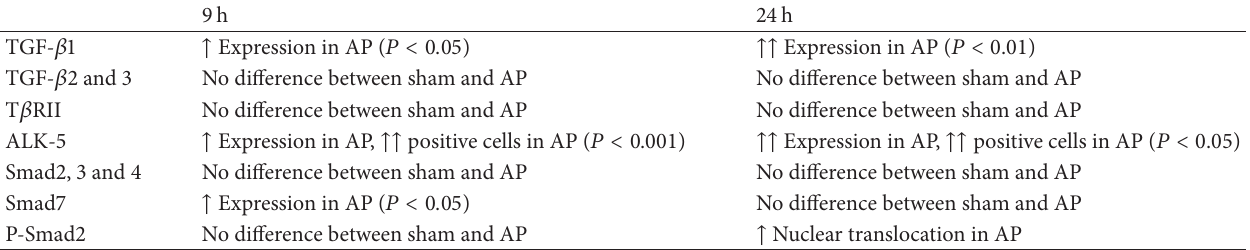
Table1:ChangesinexpressionpatternsofTGF- 𝛽 signalingmoleculesinthelungsduringacutepancreatitisattwotimepoints.Theexpression of TGF- 𝛽 signaling molecules in the lungs of AP compared to sham-operated animals based on immunohistochemistry and Western blot analyses at 9 and 24 h. AP: acute